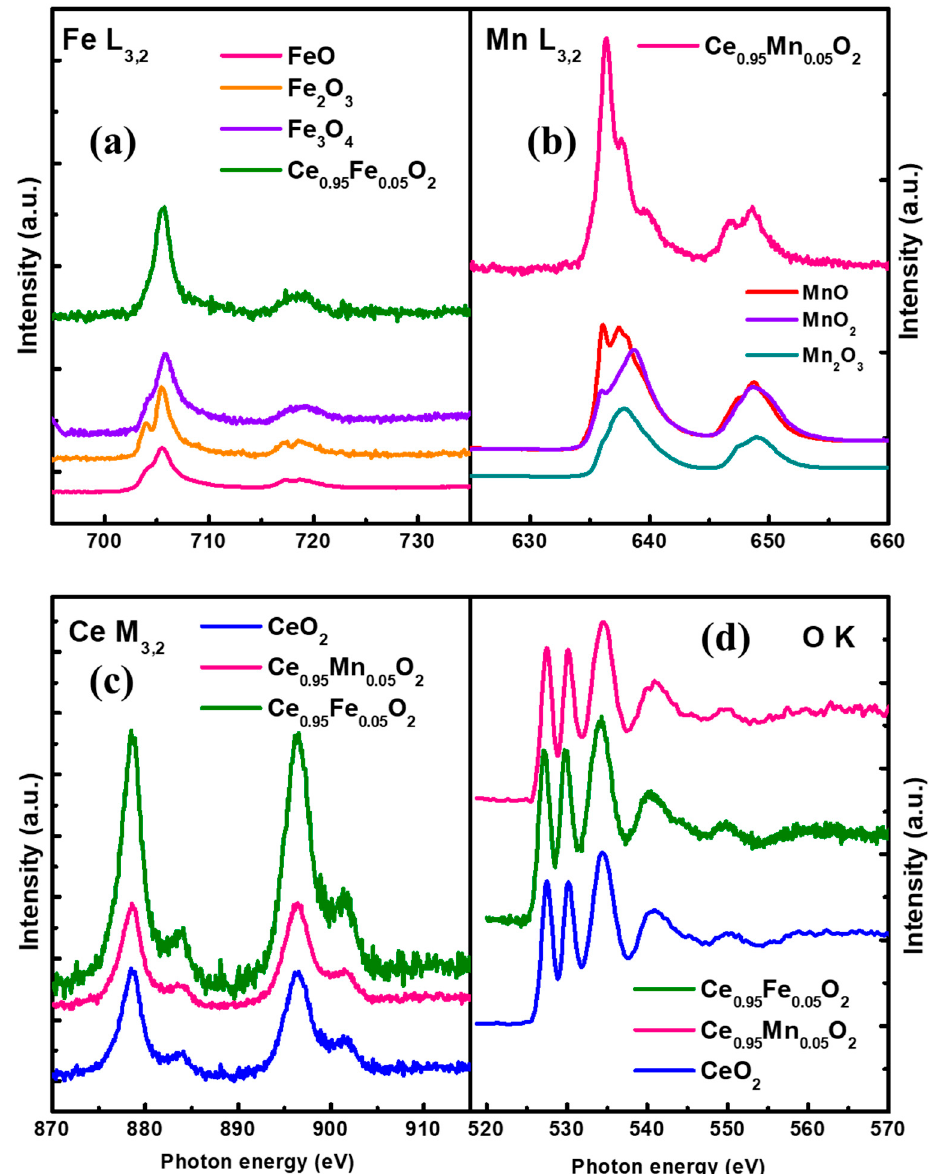
Figure 7. NEXAFS spectra of ( a ) Fe L 3,2 edge of Ce 0.95 Fe 0.05 O 2 nanoparticles; ( b ) Mn L 3,2 edge Ce 0.95 Mn 0.05 O 2 nanoparticles; ( c ) Ce M 5,4 edge undoped and CeXO 2 (X: Fe, Mn) nanoparticles, and ( d ) O K edge of undoped and CeXO 2 (X: Fe, Mn) nanoparticles.